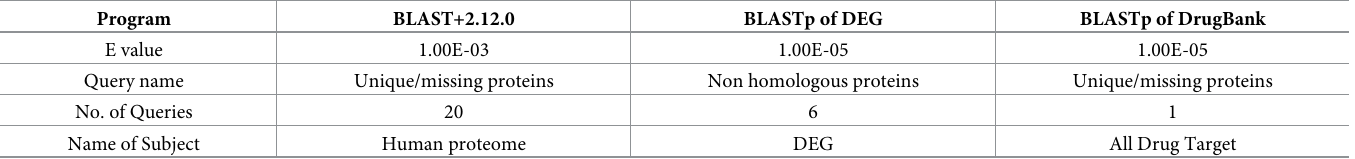
Table 2. Description of BLASTp parameters implemented and their predicted outcomes.